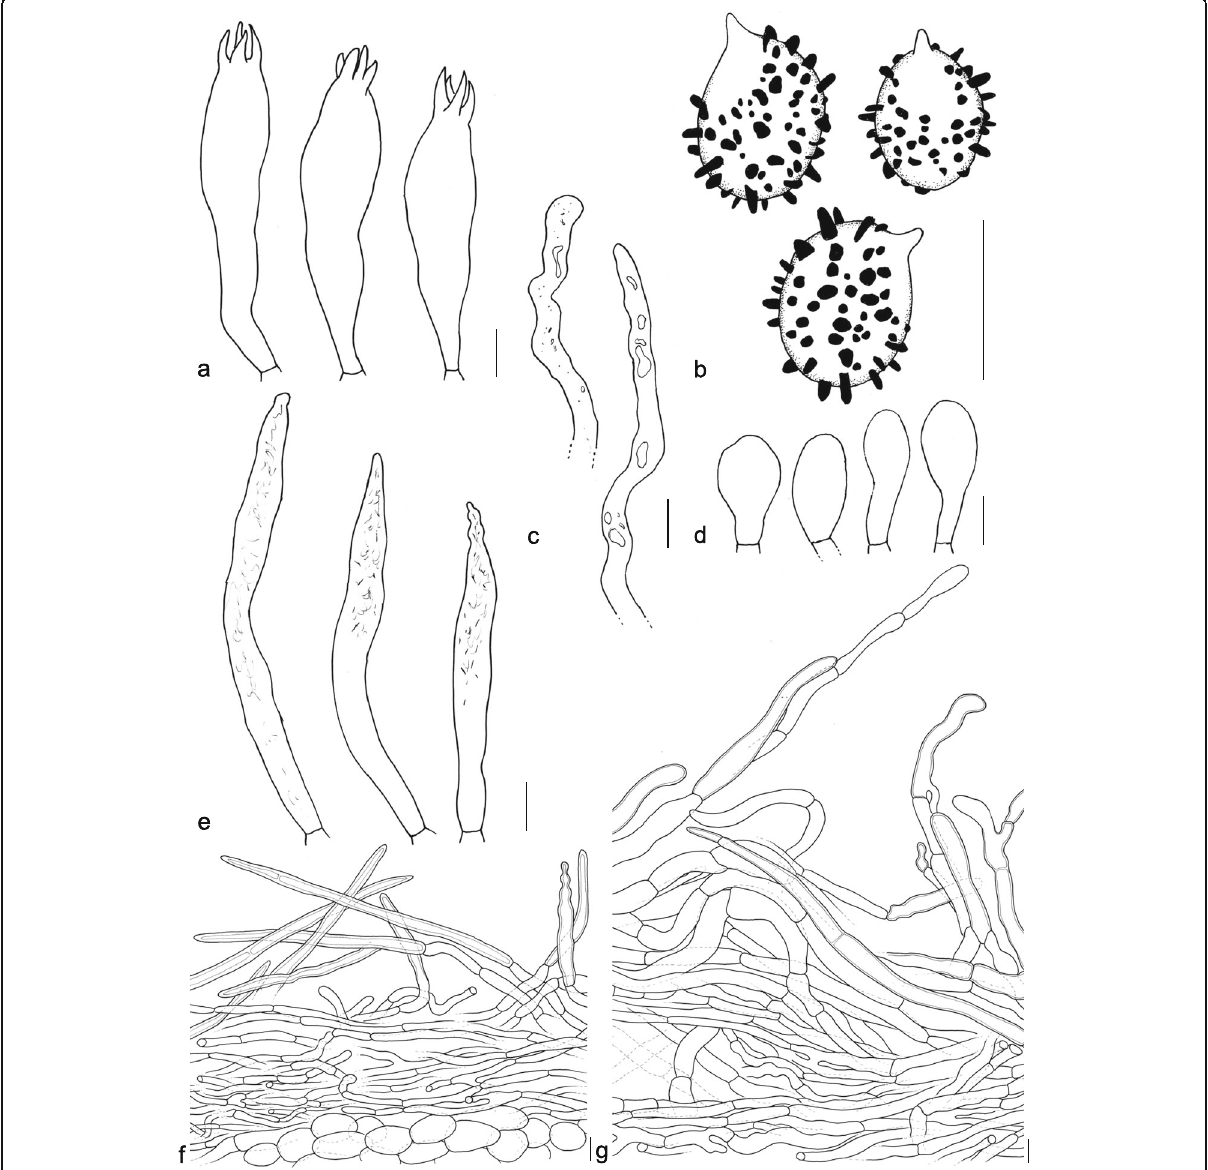
Fig. 3 Lactifluus domingensis (ANGE 542, ANGE 837, ANGE838). a Basidia. b Basidiospores. c Pseudocystidia. d Marginal cells. e Macrocystidia. f Section through the stipitipellis. g Section through the pileipellis. Bars = 10 μ